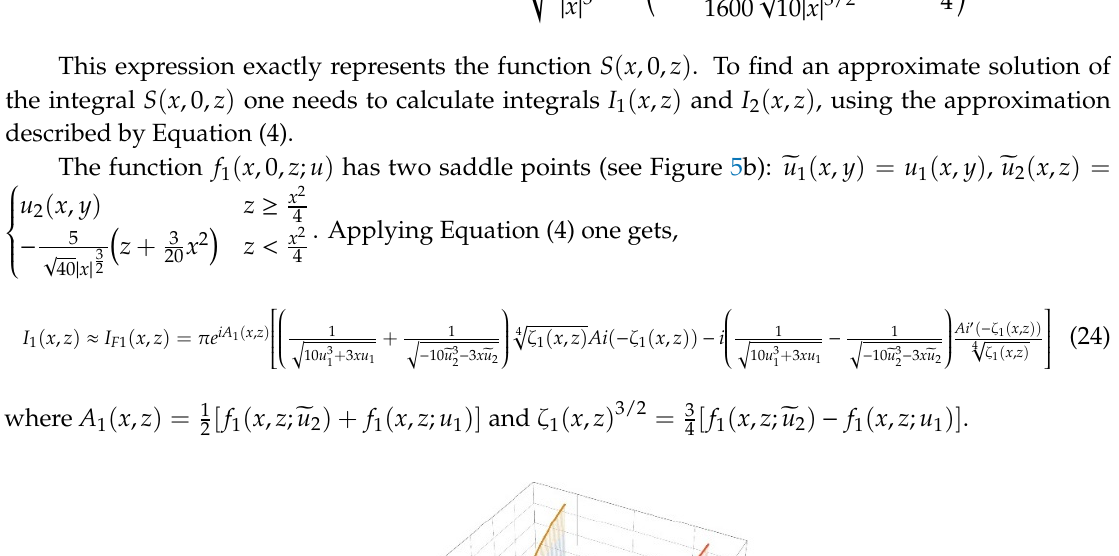
(1) ( 1,0, ; ) f z u − ( 1 ) ( − 1,0, z ; u ) ( a ), f ( 1 )